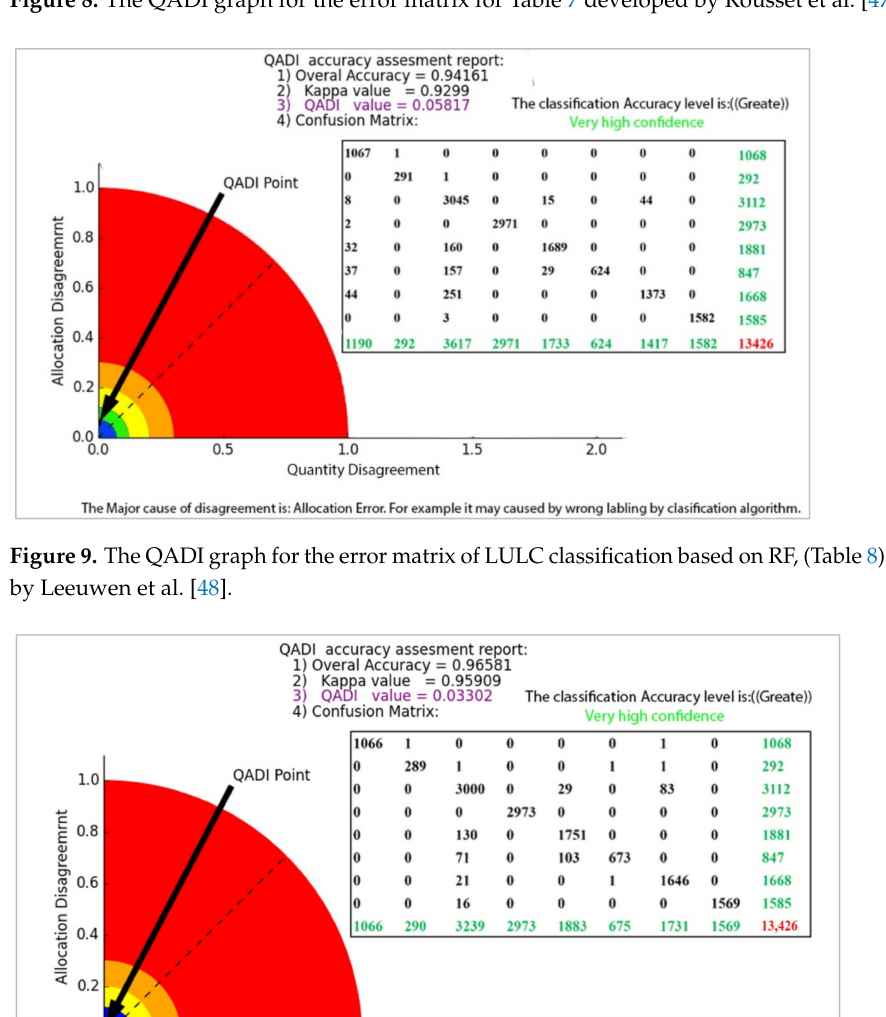
Figure 8. The QADI graph for the error matrix for Table 7 developed by Rousset et al. [47].